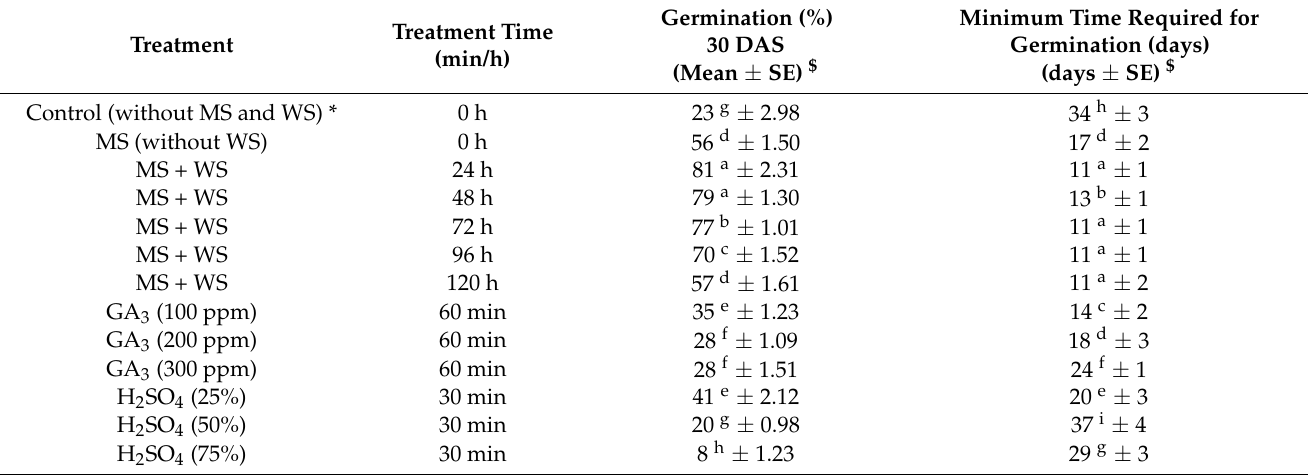
Table 1. Effect of physical and chemical treatments on seed germination of G. superba in in vivo condition 30 days after sowing (DAS) ( n = 100).